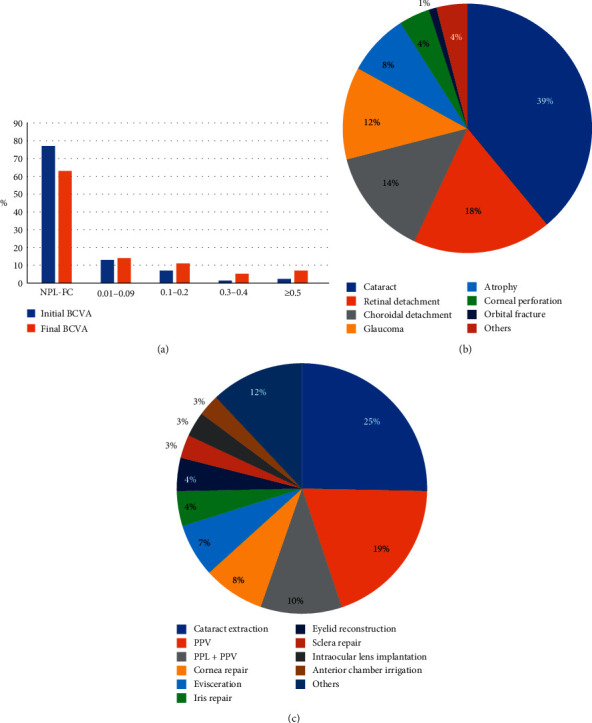
Ocular clinical features of patients with firework-related eye injury. (a) The BCVA in patients with firework-related eye injury, before and after treatment. (b) The diagnoses at admission are shown. (c) The major surgeries performed are shown. PPV, pars plana vitrectomy; PPL, pars plana lensectomy.